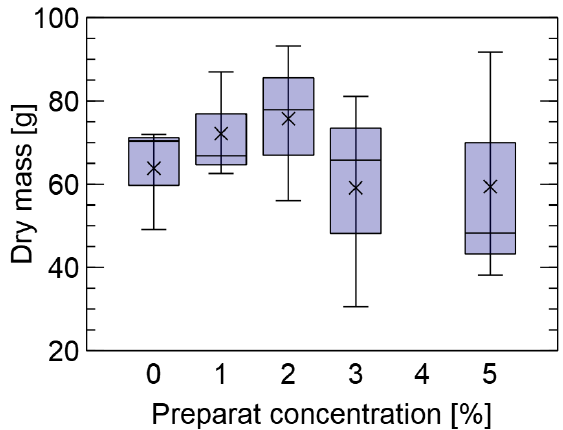
Figure 9. Dry biomass of oak seedlings versus silicon concentration, measured at the end of the experiment. The visible trend in the data was not found to be statistically significant at the p -value level of 0.05, thus, the regression fit curve is not plotted. In the plot, boxes span from the 1st to 3rd quantile, with the median indicated by a line, whiskers indicating a 1.5 inter-quantile range, and the × symbol indicating the mean